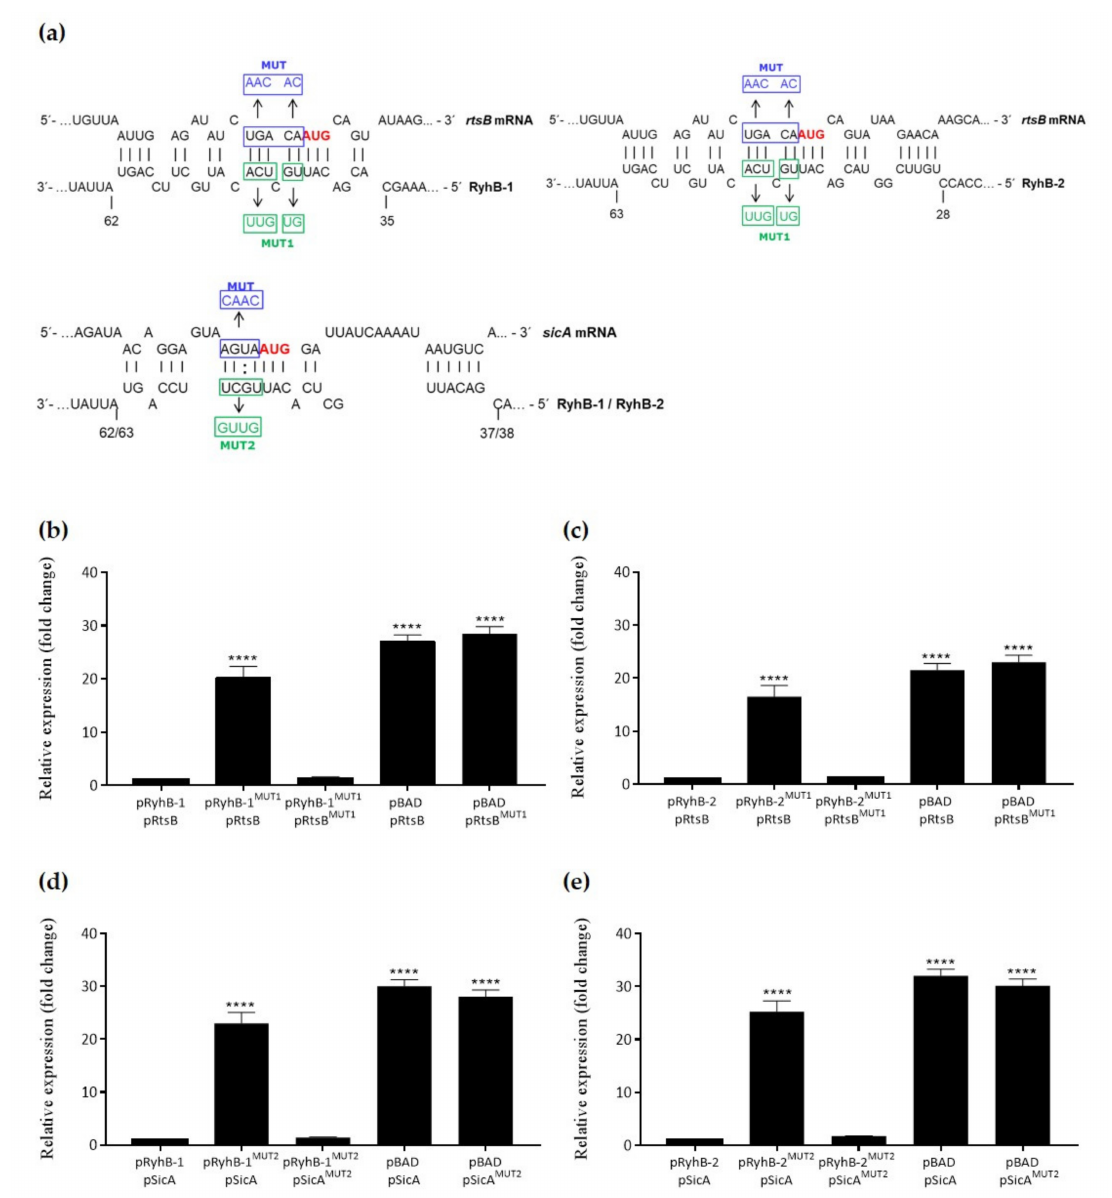
Figure 4. RyhB-1 and RyhB-2 down-regulate the rtsB and sicA expression by base-paring. ( a ) Schematic representation of the proposed interactions between the sRNAs RyhBs and rtsB and sicA mRNAs, including the nucleotide substitutions and compensatory mutations in blue boxes for the mRNAs and green boxes for the sRNAs, and the translational start sites highlighted in red. The numbers under the sRNA sequences indicate the base positions in the RyhBs. ( b – e ) Heterologous expression analyzes by two-plasmid systems. E. coli cells harboring the constitutive-expression plasmids pRtsB or pSicA plus the arabinose-inducible plasmids pRyhB-1 or pRyhB-2 were grown to exponential phase, and the expression of sRNAs was induced for 30 min by adding 0.2% arabinose. Total RNA was extracted and the relative expression of rtsB and sicA was analyzed by qRT-PCR. When required, E. coli cells were cotransformed with the corresponding mutant versions: pRtsB MUT or pSicA MUT plus the pRyhB1 MUT1 , pRyhB2 MUT1 , pRyhB1 MUT2 , or pRyhB2 MUT2 plasmids. pBAD corresponds to the control empty plasmid. Values were normalized to the levels of the 16S rRNA. The relative expression of each mRNA transcript in the mutant versions was calculated using the 2 − ∆∆ CT method and represented as the n -fold change relative to the wild type versions. Asterisks represent statistically significant differences (**** p < 0.0001). Data represent the means ± standard deviations ( n =